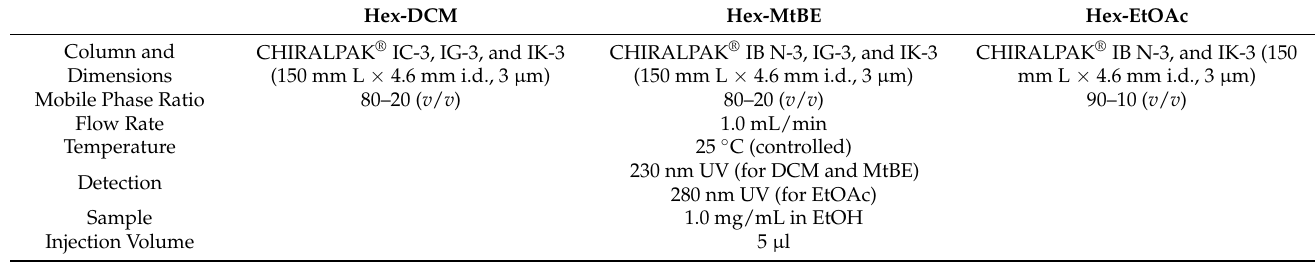
Table 2. Chromatographic performance of analytical cannabinoid separations on IK with Hex ‐ DCM ( ‐ TFA) = 80 ‐ 20 ( ‐ 0.1) mobile phases .